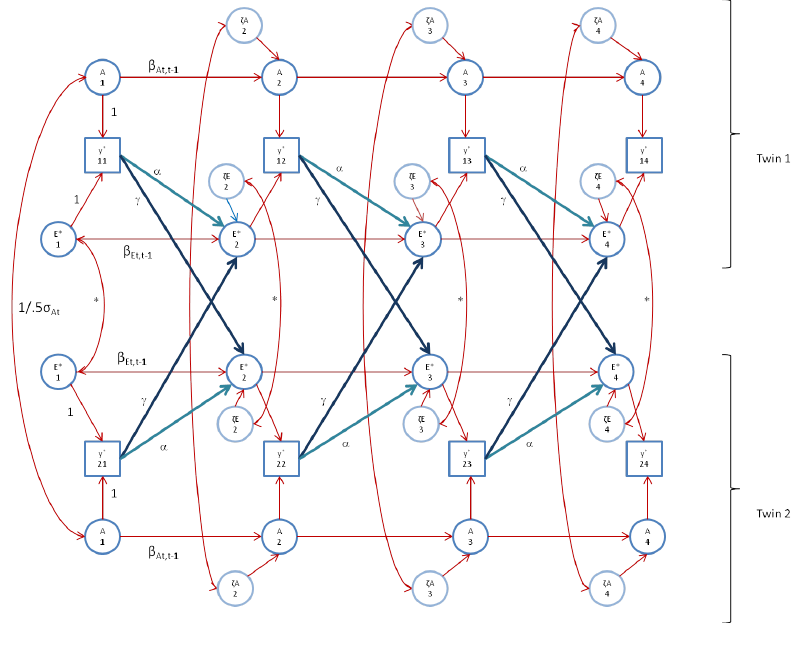
Figure 2. The AE* simplex model with Ph- >E transmission, where parameters α can be interpreted as within twin Ph->E transmission and γ as between twin Ph->E transmission, and where y’s are the series of observed variables, A’s are the underlying additive genetic series, E’s are the underlying unique environment series and * denotes the time point specific environmental covariance (indicative of C). Conform biometric theory, the covariance between the A’s at each time point is set equal to the var(A 0.5 var(A ) (for DZ twins). For clarity reasons, time specific effects and phenotypic means t are omitted. Note that the scaling and parameter labels are used throughout the